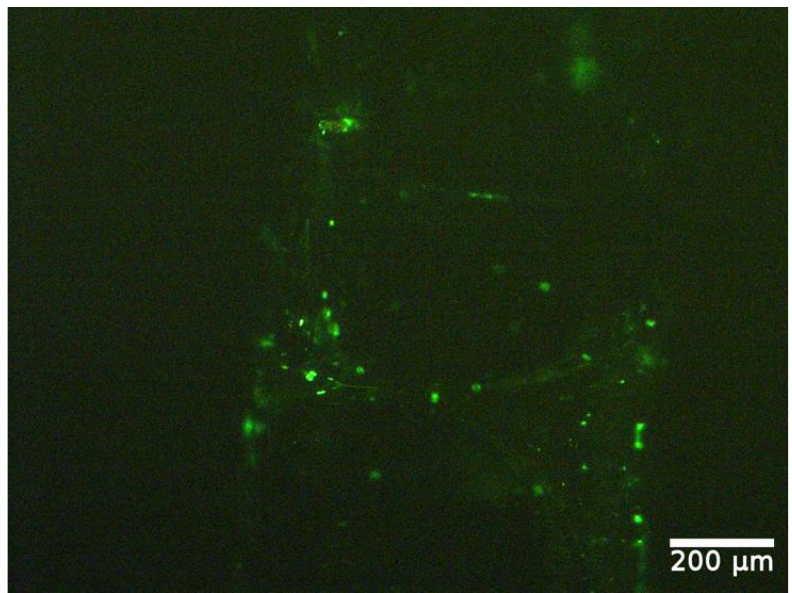
Figure 11. Apoptosis of endothelial cells after being treated with 0.5 MPa ultrasound peak negative pressure and 15 mJ/cm 2 laser fluence. Apoptotic cells show green fluorescence, and live cells show little or no fluorescence.